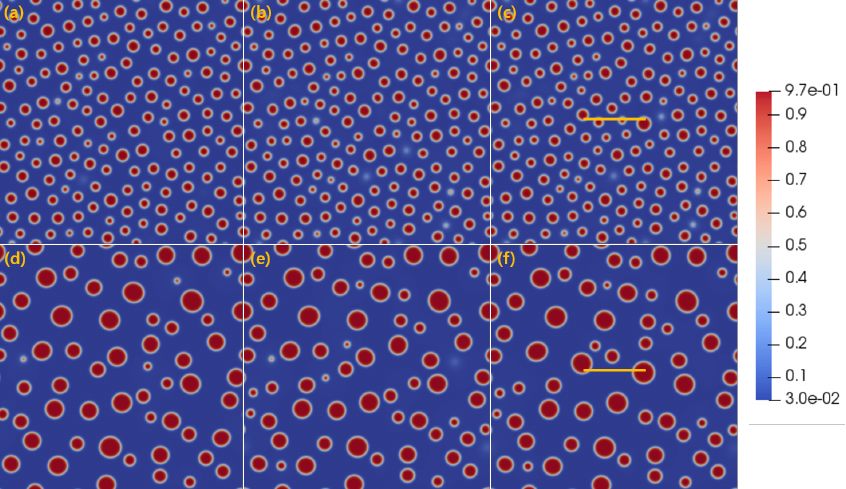
Figure 8. Microstructures of the Fe-21Cr system ( a ) without elasticity at t = 100, ( b ) with inhomogeneous elasticity without dislocation at t = 100, ( c ) with inhomogeneous elasticity and dislocation at t = 100, ( d ) without elasticity at t = 500, ( e ) with inhomogeneous elasticity without dislocation at t = 500, and ( f ) with inhomogeneous elasticity and dislocation at t = 500. The system size was 256 × 256 µ m 2 . The microstructures were visualized by Cr